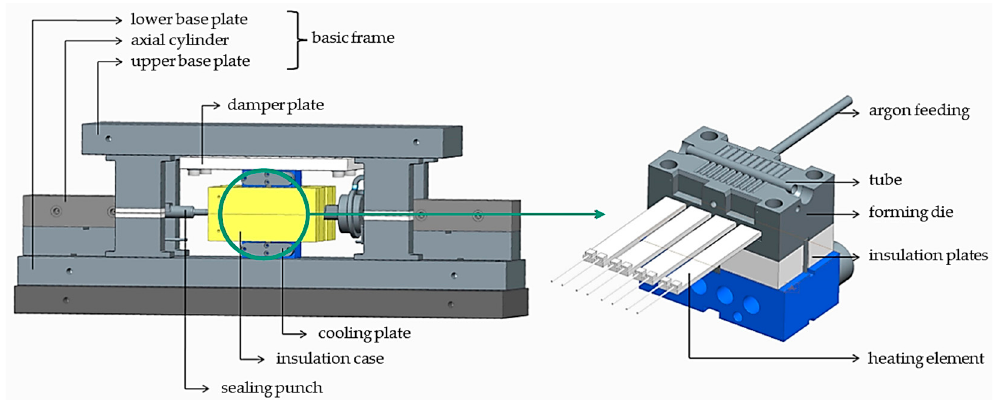
Figure 6. Basic tool setup with implemented high temperature forming die for superplastic hot tube gas forming processes. Frontal view ( left ) and sectional view ( right ).